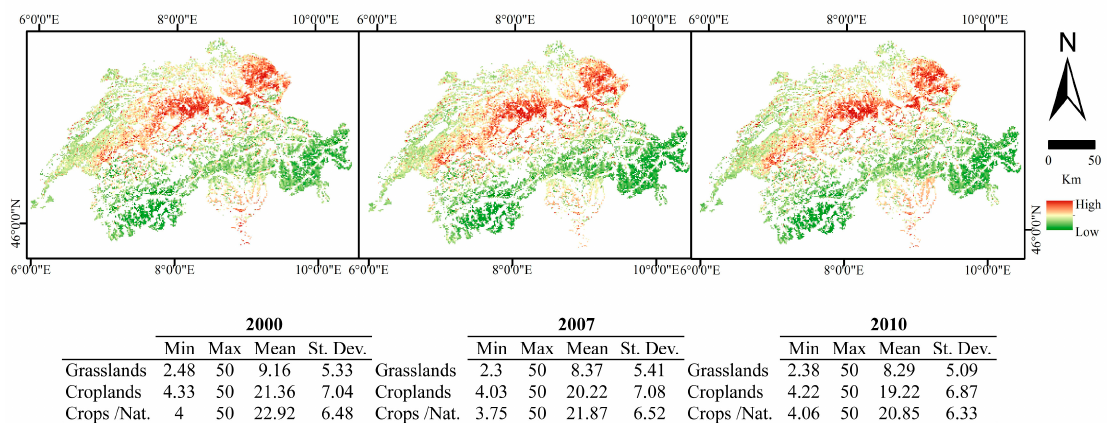
Figure A1. Spatial variability and statistics of Nitrogen deposition maps per year. Units: kg N / ha year.